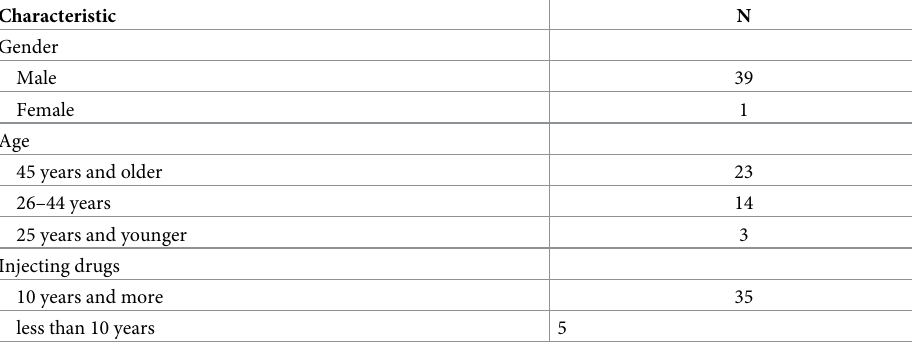
Table 2. Demographic characteristics of the